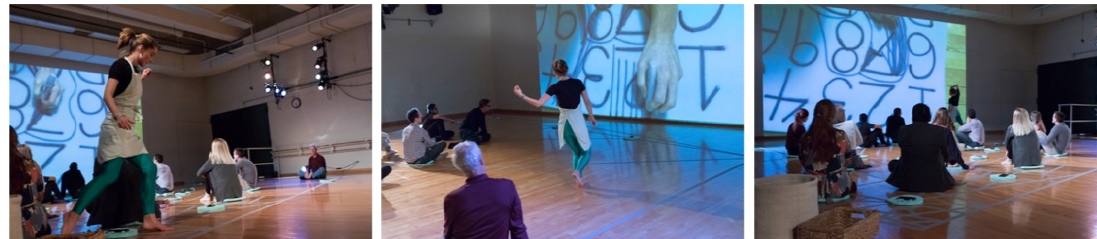
Figure 5. The closing sequence with excerpts of Elgin’s writing read alongside a final, more integrated movement sequence. Still stepping to avoid the tape on the ground, the performer increases the speed and connectedness of pathways through space; rather than treating the tape like a constraint, she treats it like a rhythm that pushes the pace of the movement and creates a comfortable stride timing. Photos by Natalie